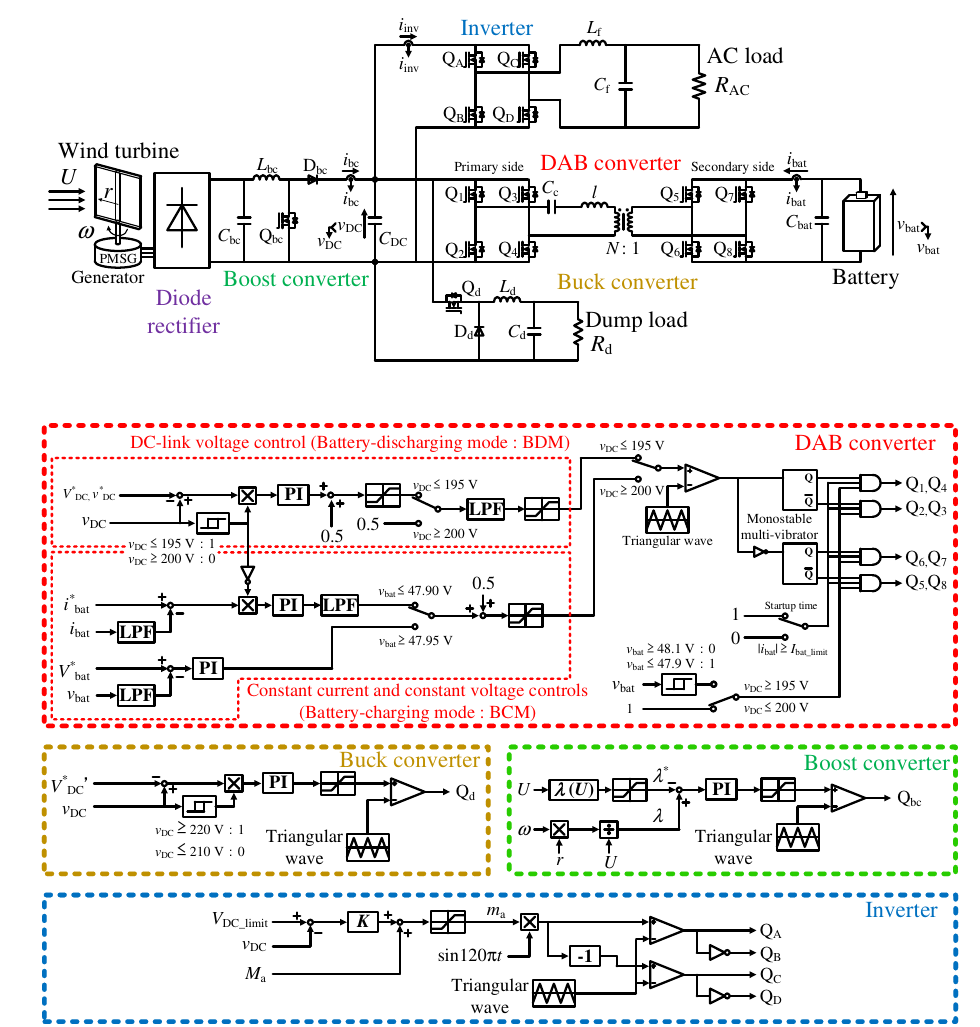
Figure 4. Standalone WPGS with a DAB